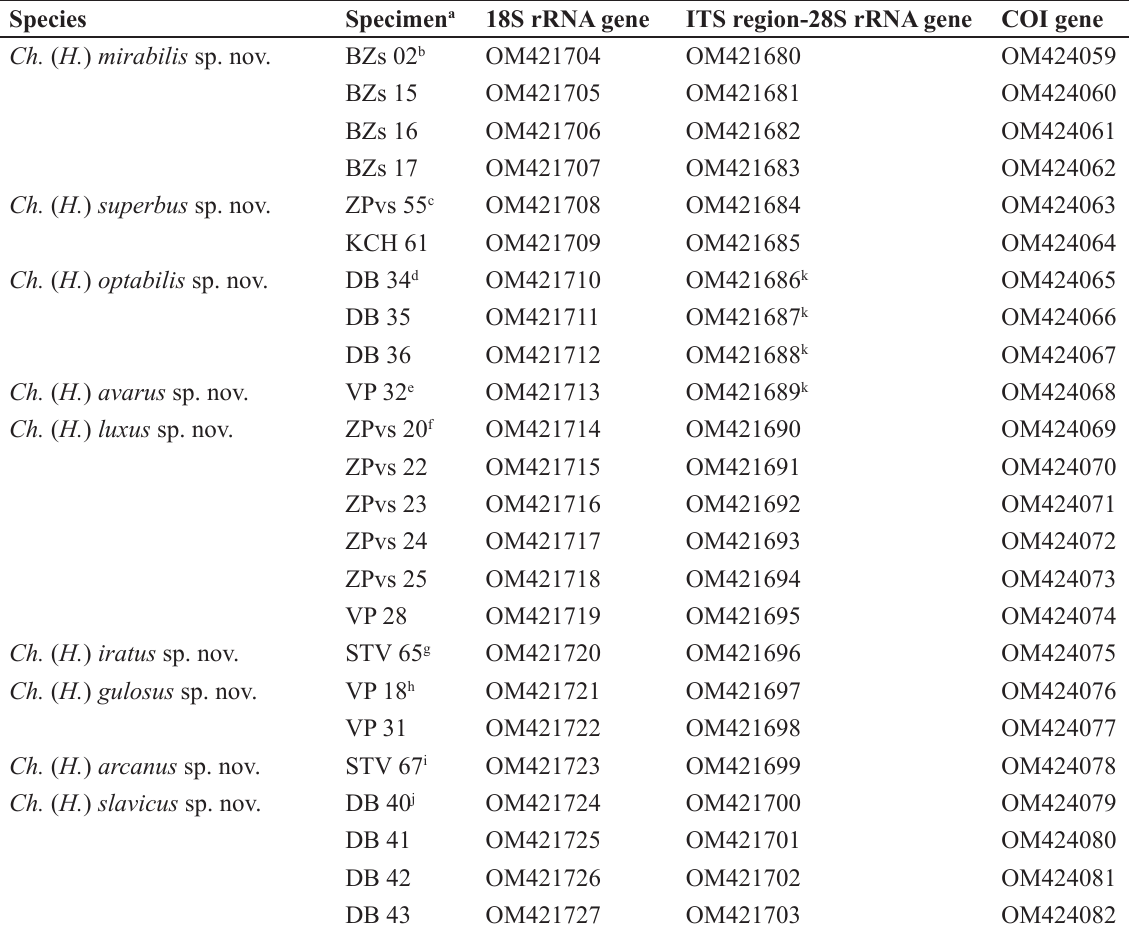
Table 2. GenBank accession numbers of nuclear and mitochondrial gene sequences of nine new species of the subgenus Hystricochaetonotus Schwank,